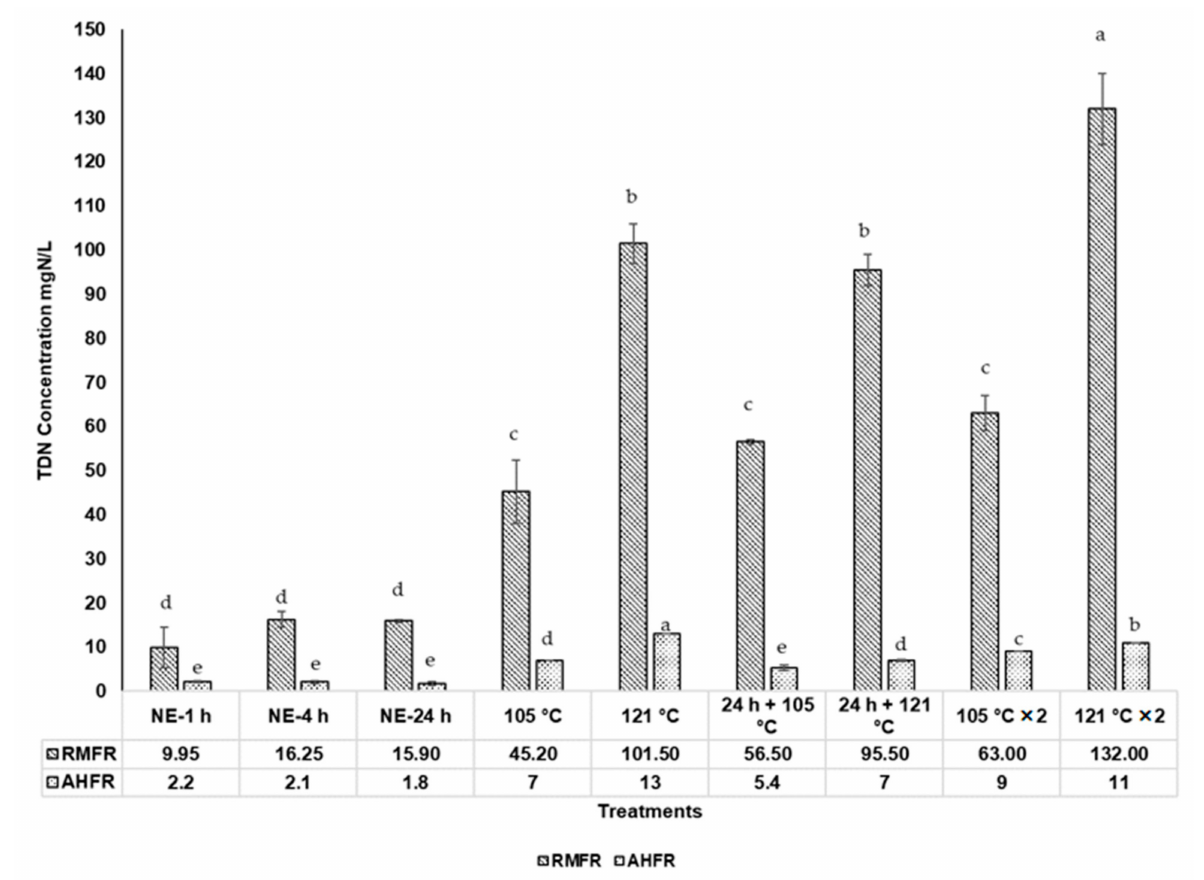
Figure 1. Total dissolved nitrogen (TDN) concentrations in soil extract from different extraction methods; Raja Musa Forest Reserve (RMFR) and Ayer Hitam Forest Reserve (AHFR) for nine different extraction methods; (NE-1 h-soil extracted at room temperature 1 h; NE-4 h-soil extracted at room temperature 4 h; NE-24 h-soil extracted at room temperature 24 h; 105 ◦ C—autoclave 105 ◦ C; 121 ◦ C—autoclave 121 ◦ C; 24 h + 105 ◦ C—autoclave 105 ◦ C after natural extraction 24 h; 24 h + 121 ◦ C—autoclave 121 ◦ C after natural extraction 24 h; 105 ◦ C × 2—autoclave 105 ◦ C twice; 121 ◦ C × 2—autoclave 121 ◦ C twice. Error bars represent standard deviation ( n = 3). a–e Mean value with different superscripts are significant different ( p < 0.05) using ANOVA and Turkey